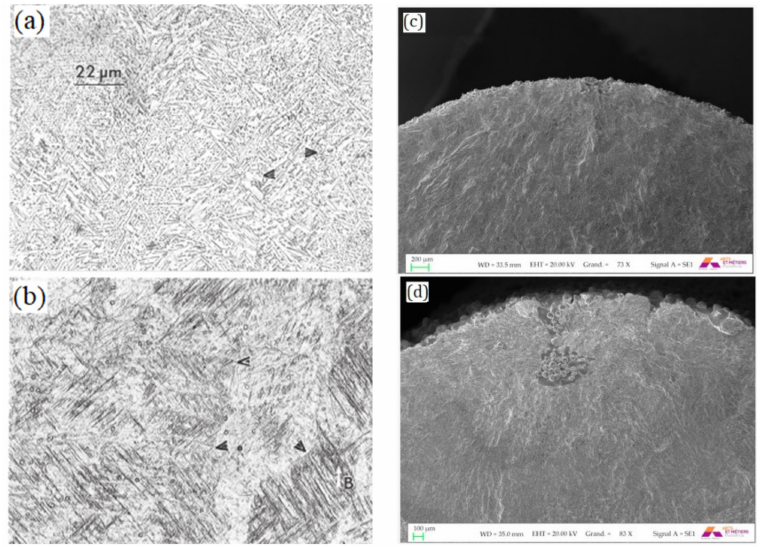
Figure 8. Comparison of the microstructures for ( a ) EBM and ( b ) SLM and the surface roughness for ( c ) SLM and ( d ) EBM for Ti6Al4V